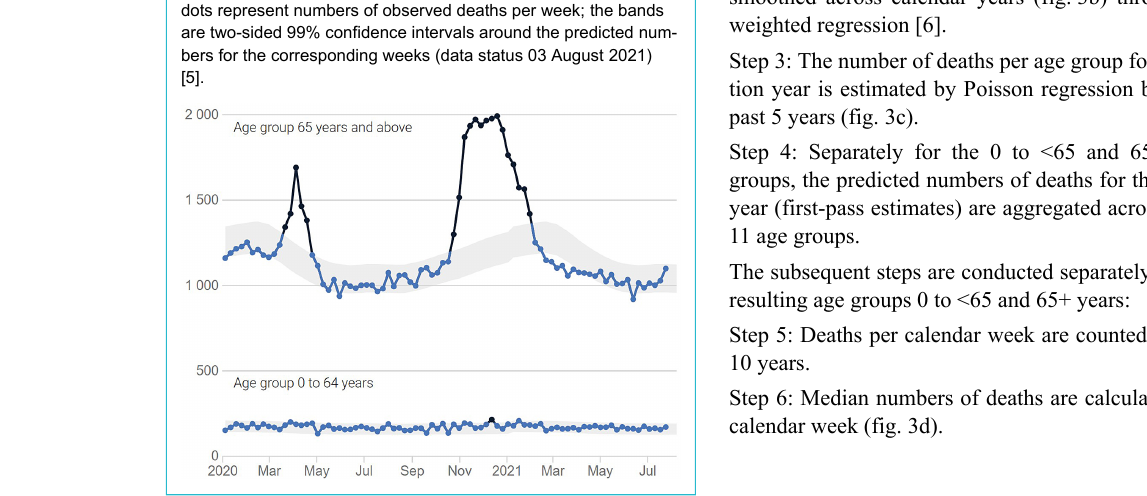
Figure 2: Federal Statistical Office web publication on the weekly number of deaths in Switzerland by age group (with completed years of life), from week 1, 2020 to week 29, 2021. The connected dots represent numbers of observed deaths per week; the bands are two-sided 99% confidence intervals around the predicted num- bers for the corresponding weeks (data status 03 August 2021)